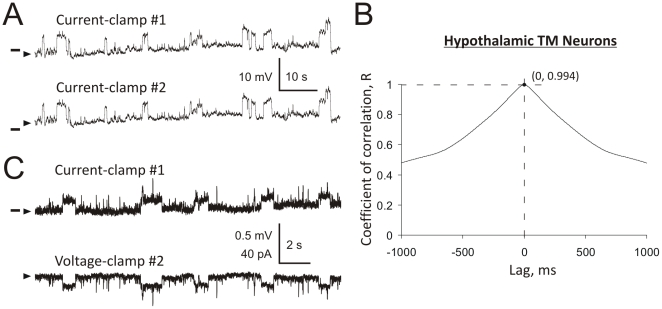
Analysis of cross-correlations and space-clamp in hypothalamic TM neurons.An example of traces recorded by two patch-clamp electrodes in current-clamp (A). Results of cross-correlation analysis (B). The correlation coefficient at lag = 0 ms (R = 0.9993) was used to estimate the significance of cross-correlation between the two traces (see Methods). Results obtained in the same experiment when electrode #2 was switched to voltage-clamp at −70 mV (C). Electrode #1 remained in current-clamp and detected small (∼0.22 mV) space-clamp errors (C, top trace) in the quality of voltage-clamp provided by electrode #2. Horizontal bars indicate the membrane voltage of −70 mV (A) and −70.2 mV (C). A continuous hyperpolarizing current (50–120 pA) was injected into cells to cease spontaneous firing (A). The baselines are indicated by arrowheads.